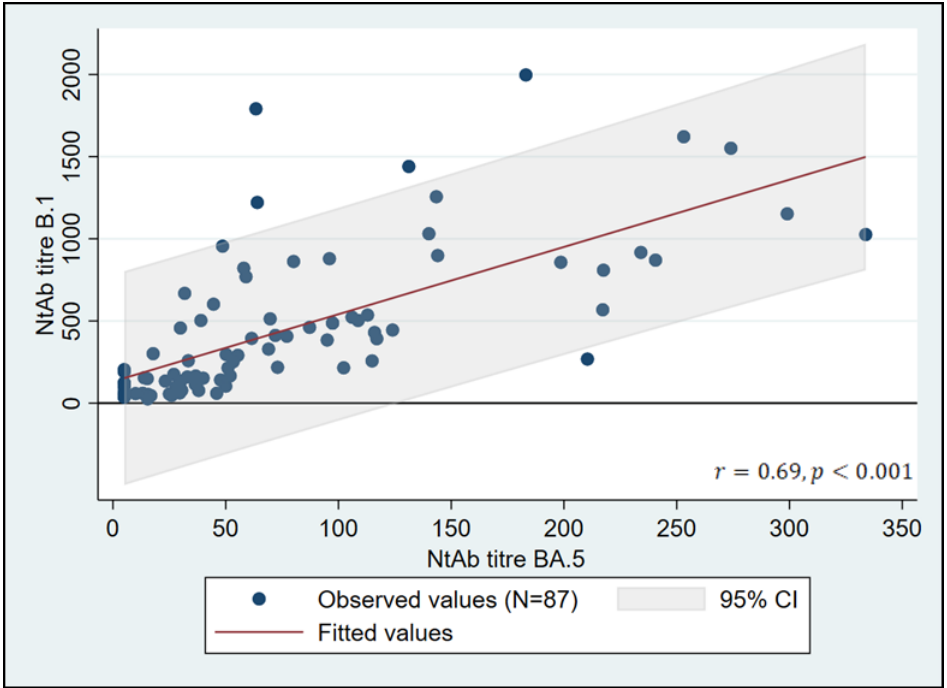
Figure 2. Linear regression between B.1 and BA.5 titers in HIV patients 6 months after the third BNT162b2 vaccine dose (outliers excluded from cohort). NtAb titers are expressed as ID 50 , which is the reciprocal value of the sera dilution and shows 50% protection from the virus-induced cytopathic effect.